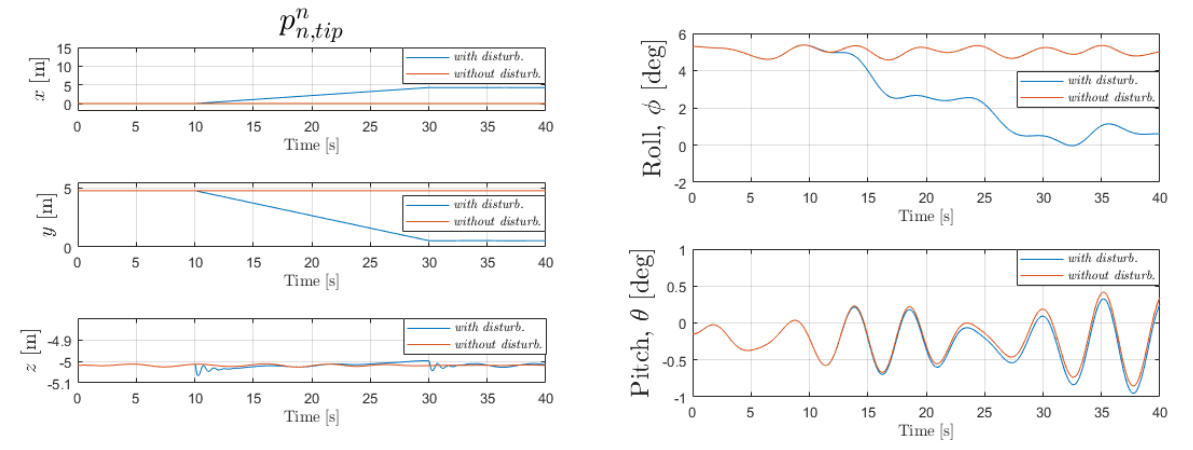
Figure 5: x , y and z coordinates of the crane tip rel- ative to and expressed in coordinates of in- ertia frame { n } . The red graph represents a simulation where the crane tip was kept stationary. In this case, the crane links ( a 2 and a 3 ) lies in the yz -plane of inertia frame { n } . The blue graph illustrates a simulation of the crane tip, where the crane links lies initially in the yz -plane of { n } , from 10 to 30 seconds the crane tip moves linearly to a position where the crane links lies in the xz - plane of inertia { n } .